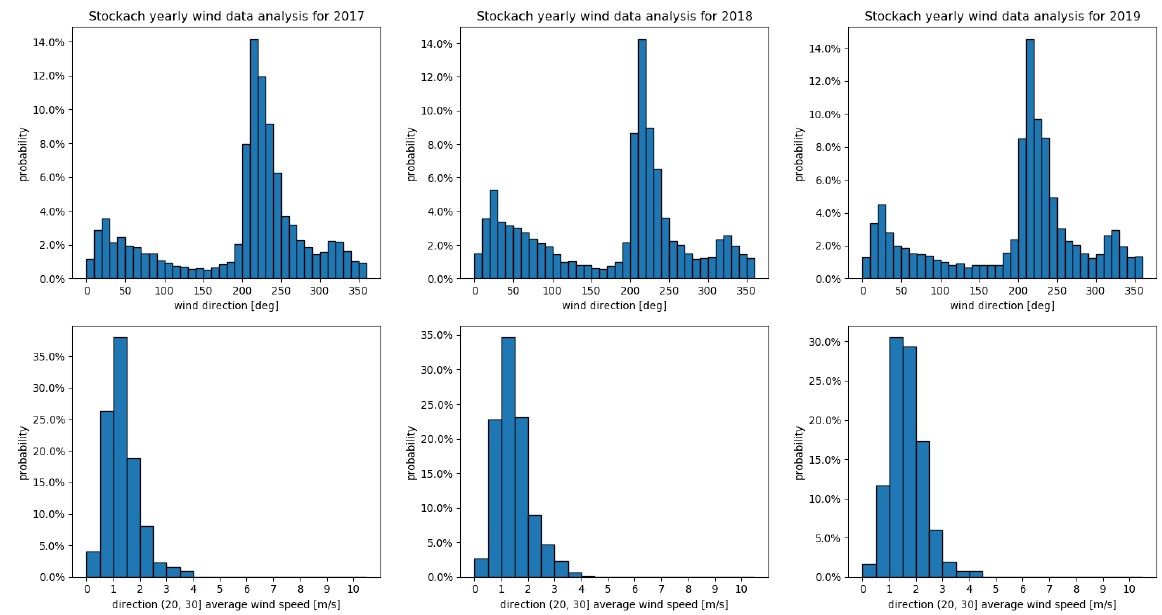
Figure 4. Annual wind direction and wind speed (for NNE direction) probabilities for the years [2017-2019] in the St ¨ ockach area.